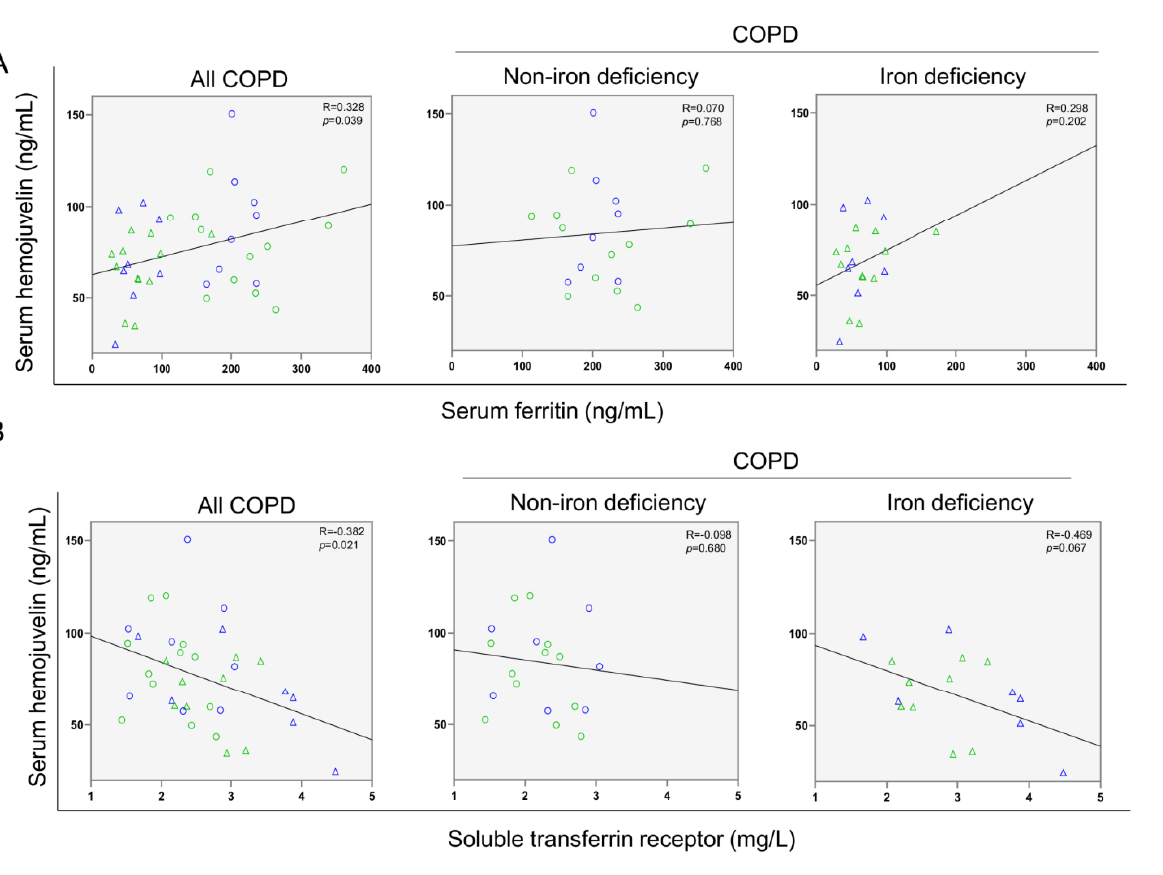
Figure 7. Scatter plots representation of correlations between serum hemojuvelin levels and serum ferritin ( A ) and soluble transferrin receptor ( B ) in all COPD patients ( left panels), non-iron deficiency ( middle panels) and iron deficiency ( right panels) COPD patients. In the scatter plots, the green color dots or triangles indicate male patients in either study group, while the blue color dots or triangles indicate female patients in the same groups. Definition of abbreviations: COPD, chronic obstructive pulmonary disease.